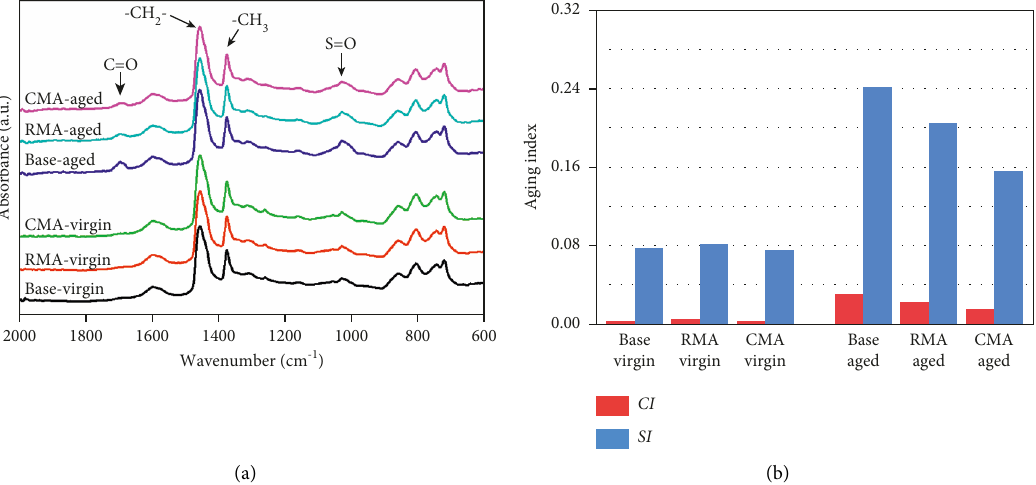
Figure 3: ATR-FTIR spectra of virgin and aged asphalt samples.